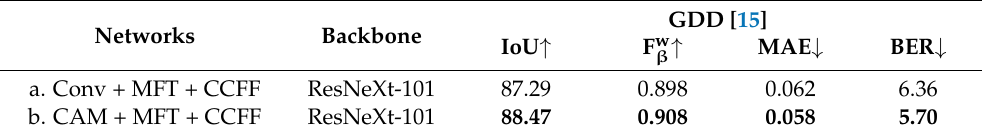
Table 4. CAM module ablation experimental results: “conv” refers to the extraction of back- bone features at different levels using convolutional methods, and “CAM” denotes our contextual attention